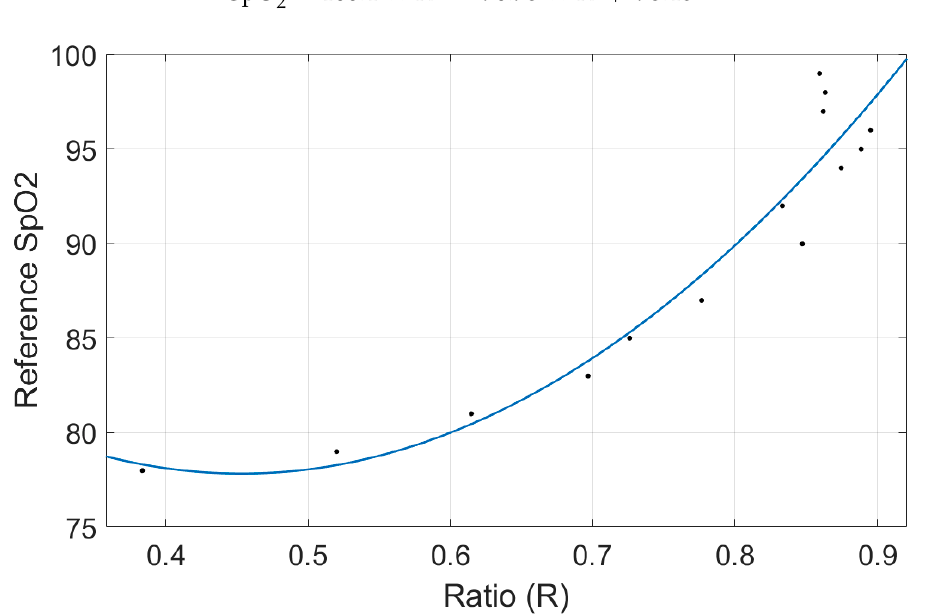
Figure 13. SpO 2 calibration curve for our proposed wearable PO device.